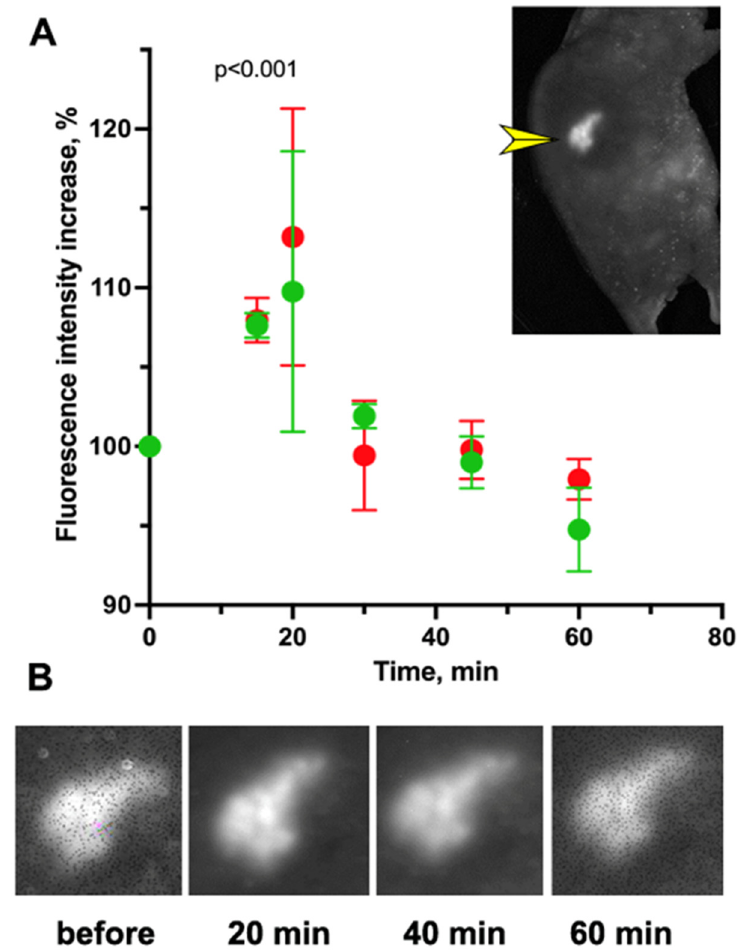
Figure 4. Gadobutrol (GB)-assisted OC effect in E9 tumor xenograft (A549-St dCas9 EGFP-Nm/ dCas9-mCherry) after Dox-induced chimera expression in mice on the 3rd day; ( A ) E9 tumor/to skin normalized mCherry fluorescence on the 3rd day in two animals (red and green) after Dox induction and using 0.7 M GB as an OC agent before and after (15–60 min) GB application, p < 0.001 (Wilcoxon–Mann–Whitney test, n = 6–12/time points, data shown as mean ± SD). Inset: mouse planar fluorescence imaging (ex 502–547 nm, em 570–640 nm) at the optimized time point chosen from FI dependence on time. Yellow arrowhead points to a subcutaneous tumor; ( B ) Tumor FI images which correspond to the time points on the graph ( A ) reflecting the kinetics of FI changes.